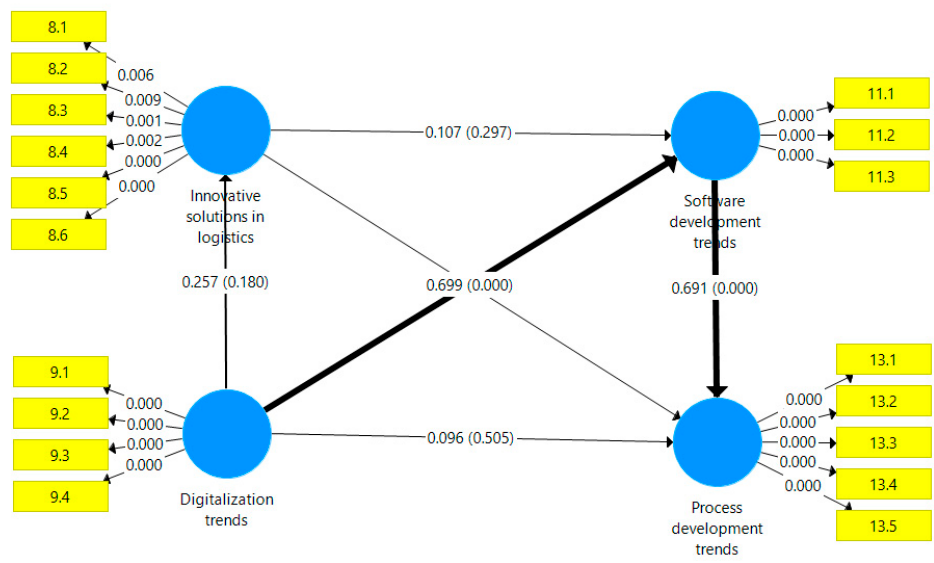
Figure 4. PLS path Figure 4. PLS path model.